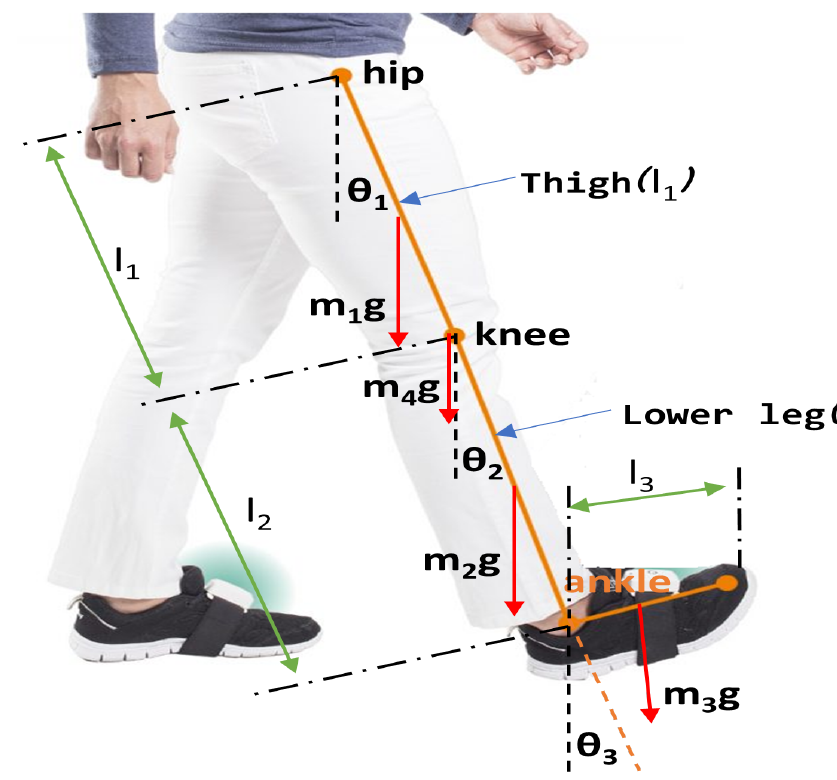
Figure 6. Force balance diagram of the lower